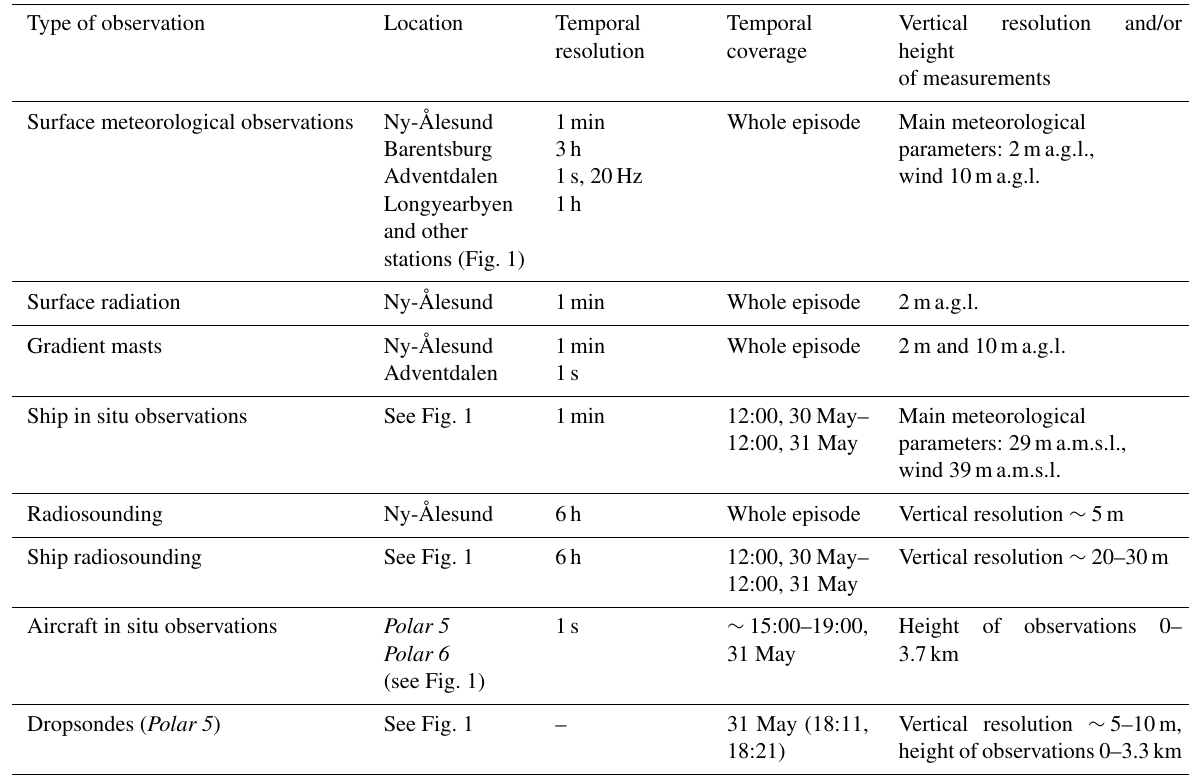
Table 1. Observations during foehn episode. Type of observation Location Temporal